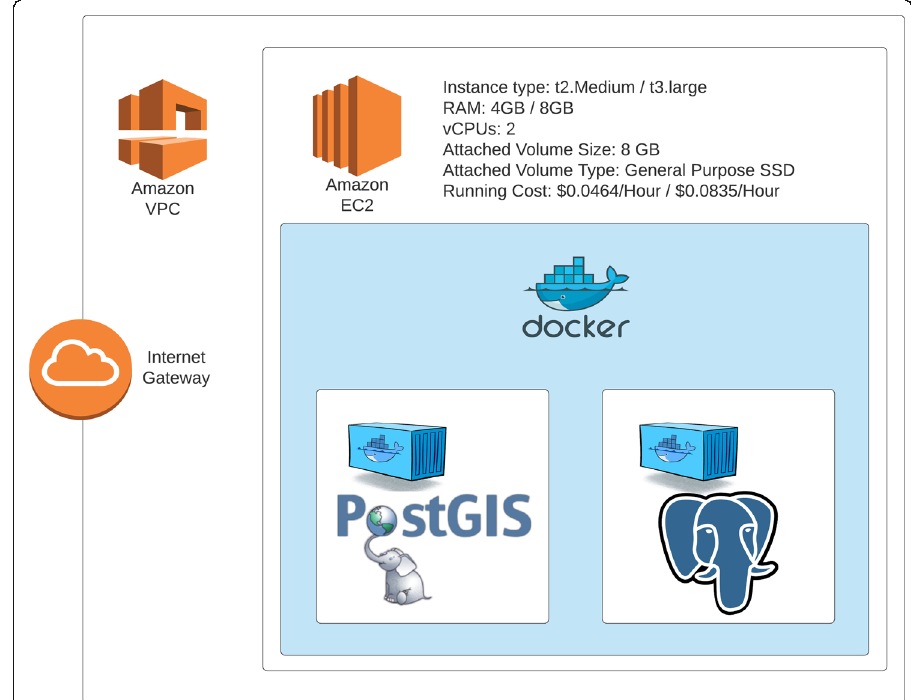
Fig. 2 Cloud infrastructure setup for deploying PostgreSQL/PostGIS on AWS